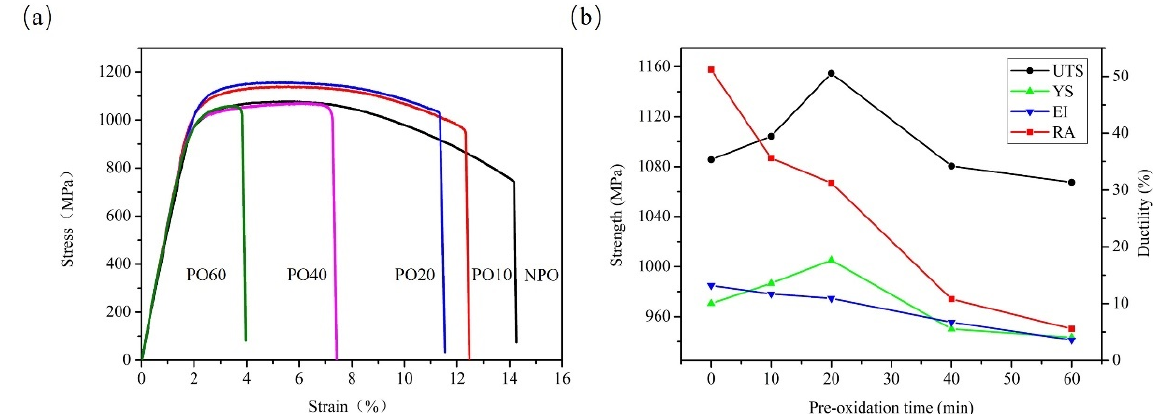
Figure 6. Tensile curves and the changing trend of tensile properties of specimens with and without the alpha-case: ( a ) the tensile curves, and ( b ) the changing trend of tensile properties.